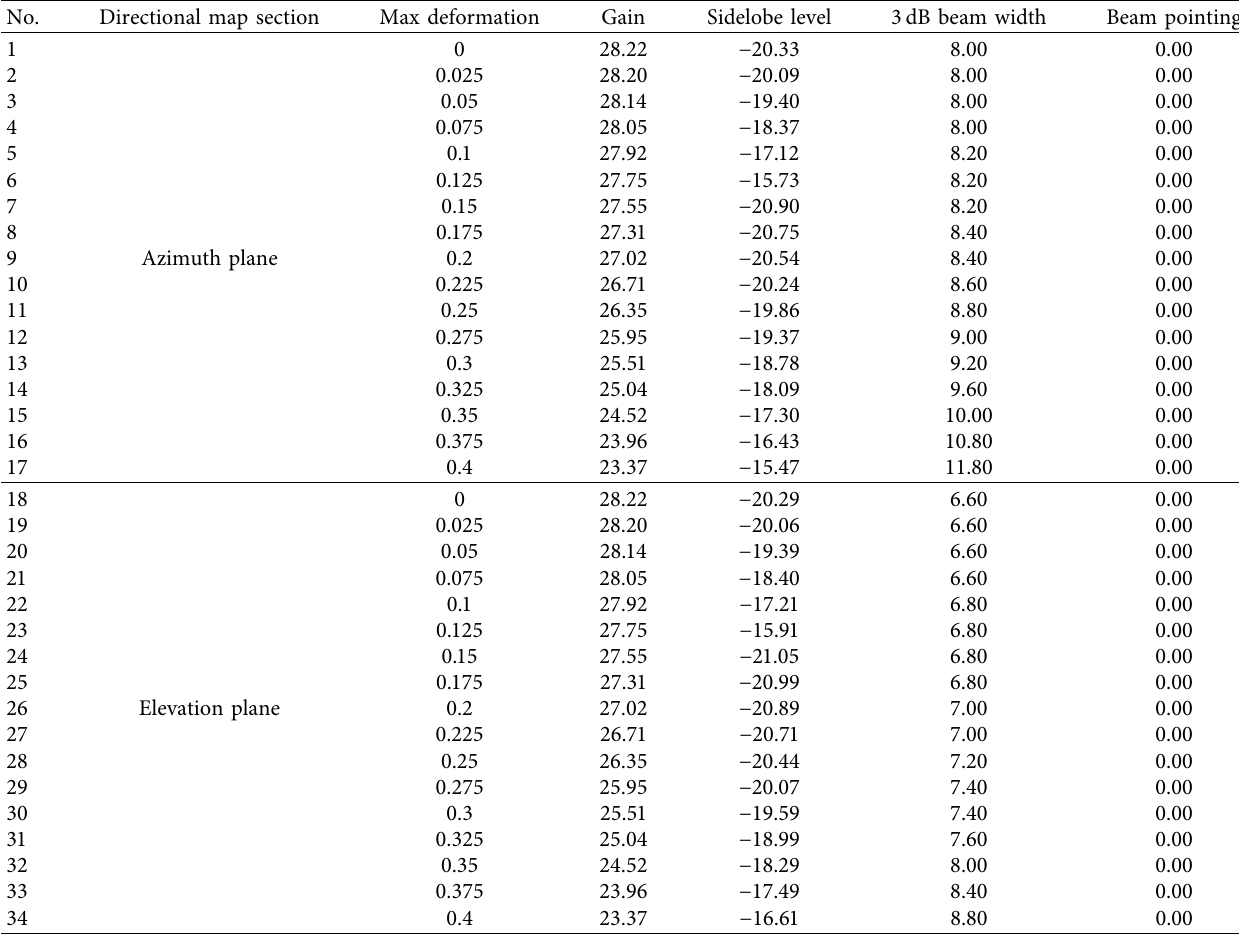
Figure 21: Changes in technical indicators of elevation plane caused by saddle-shaped deformation. (a) Gain. (b) Sidelobe level. (c) Beam width. (d) Beam Table 5: Statistics of saddle-shaped deformation technical indicators.